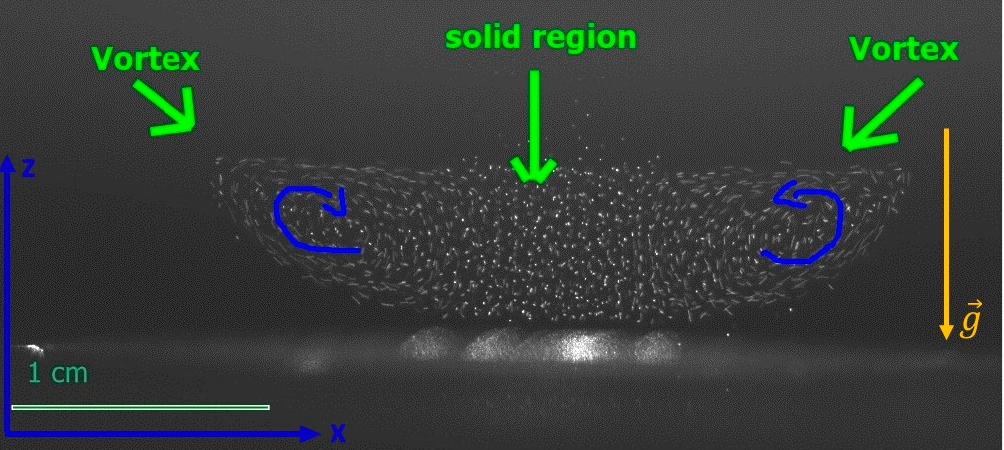
Figure 2. Lateral view of dusty plasma crystal with two vortexes formed of 250 mTorr and 2 W.